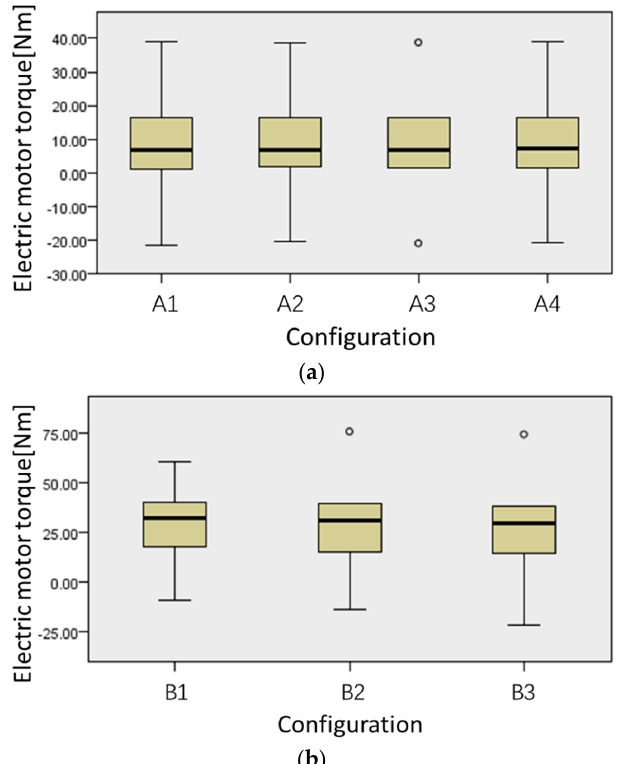
Figure 17. Box charts of electric motor torque under ( a ) Configurations A1–A4 and ( b ) Configuration B1–B3. Energies 2018 , 11 , x Table 21. Comparison of two parameters under different configurations.